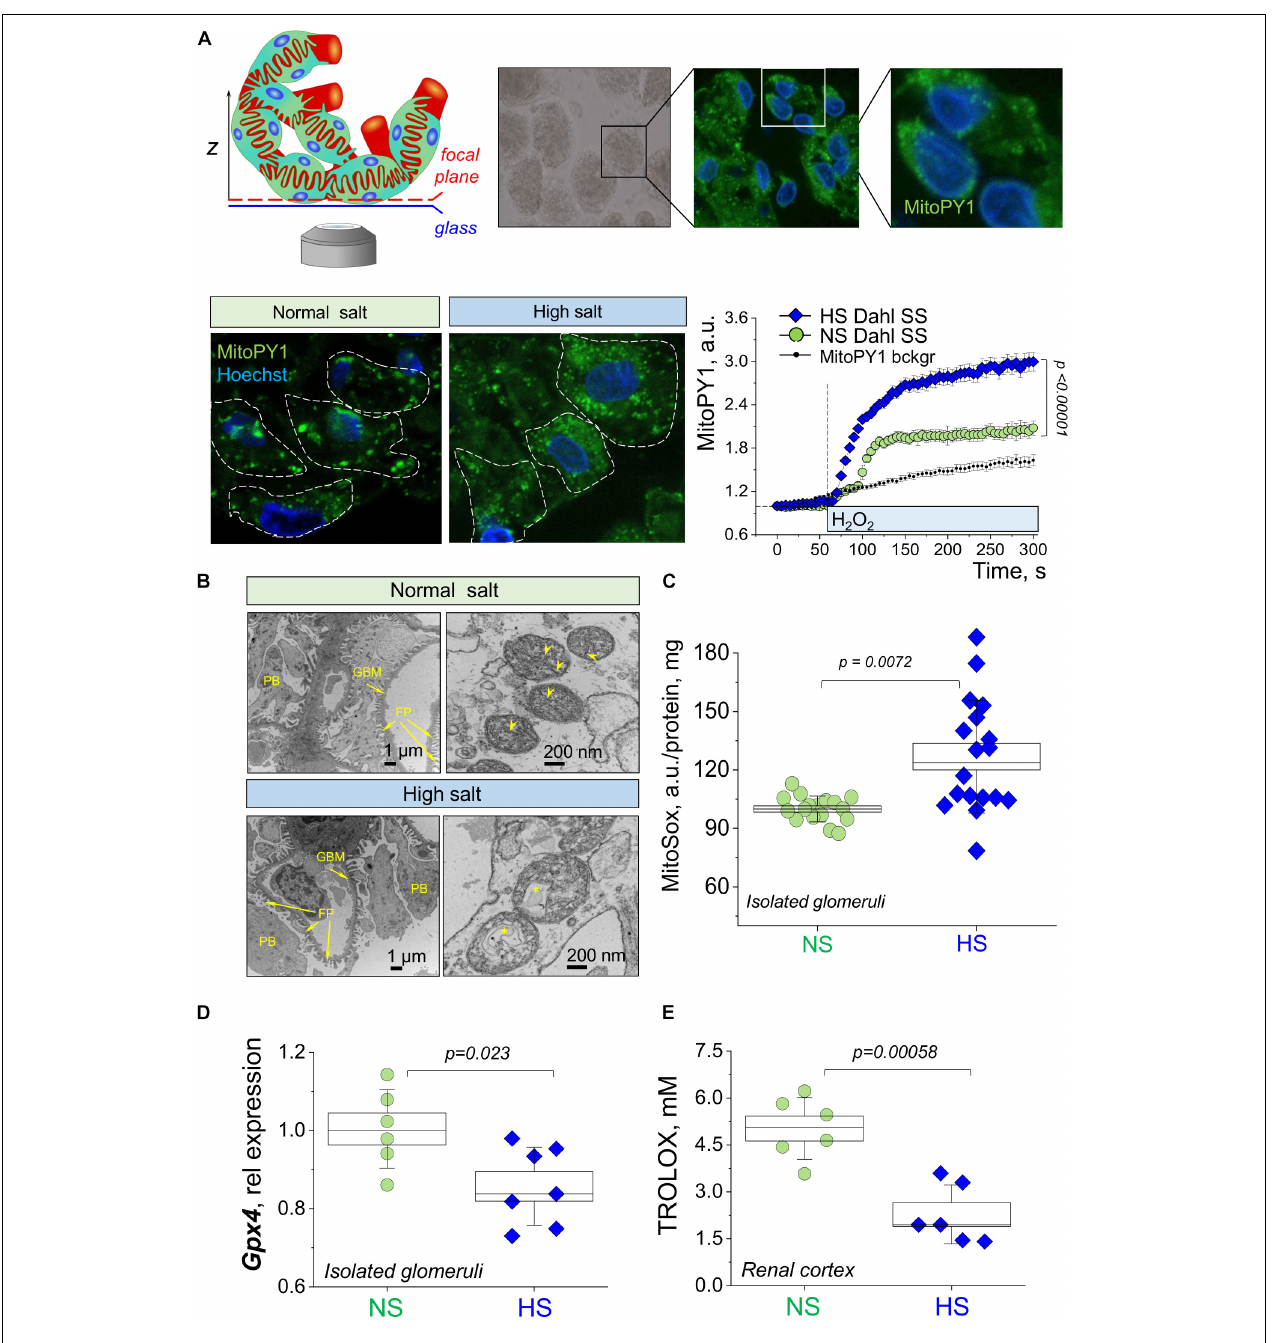
FIGURE 5 | Structural and functional properties of glomerular mitochondria in salt-sensitive (SS) hypertension. (A) A schematic illustration of the imaging configuration, as well as representative images of the podocytes in the isolated glomeruli stained with mitoPY1 to visualize H 2 O 2 in mitochondria (green), and Hoechst (blue) to label nuclei. Images were obtained with a 63 × oil objective, NA 1.4. Dotted lines show podocyte body outlines (obtained from TL images). Graph on the right summarizes the fluorescence transients obtained from mitoPY1-stained podocytes of freshly isolated glomeruli in response to acute addition of 10 µ M H 2 O 2 . Background auto fluorescence of mitoPY1 is shown (transient obtained in the absence of H 2 O 2 ). N , five rats per group, at least four glomeruli per animal, with five to nine ROIs (podocytes) analyzed per glomerulus. Statistical analysis performed using one-way repeated measures ANOVA with Holm–Bonferroni for post hoc means comparison. (B) Representative electron microscopy images of the mitochondria ultrastructure in the podocyte of the glomeruli isolated from NS and HS diet fed rats. Scale bar is shown on the graph; asterisk denotes autophagosome formation; arrowheads show cristae. FP, foot processes; GMB, glomerular basement membrane; PB, podocyte body. (C) Mitochondria of glomeruli of HS diet fed animals exhibit higher levels of super oxide, as shown by fluorescence of MitoSox, six rats in each group, three replicates were measured per each experimental animal. Data were compared using a one-way ANOVA with Holm–Sidak post hoc test. (D) Relative expression of Gpx4 in the fraction of freshly isolated glomeruli. (E) The antioxidant capacity of renal cortical tissue compared in NS vs. HS diet fed animals (expressed in mM Trolox). Data were compared using a one-way ANOVA with Holm–Sidak post hoc test, each point represents a separate animal.